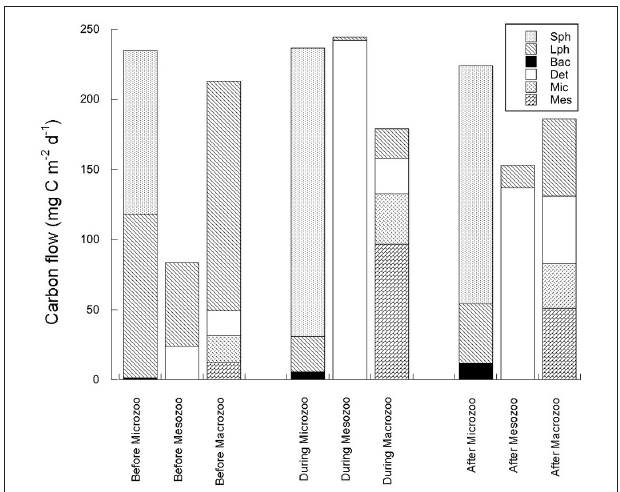
FIGURE 3 | Carbon flow, predicted by the inverse modeling, through the zooplankton compartments (microzooplankton < 200 µ m, mesozooplankton, 200–100 µ m and macrozooplankton ( > 1,000 µ m) during three time periods in the Fram Strait, before, during and after the warm water event of 2005–2007. Compartment identification as in Figure 2 .